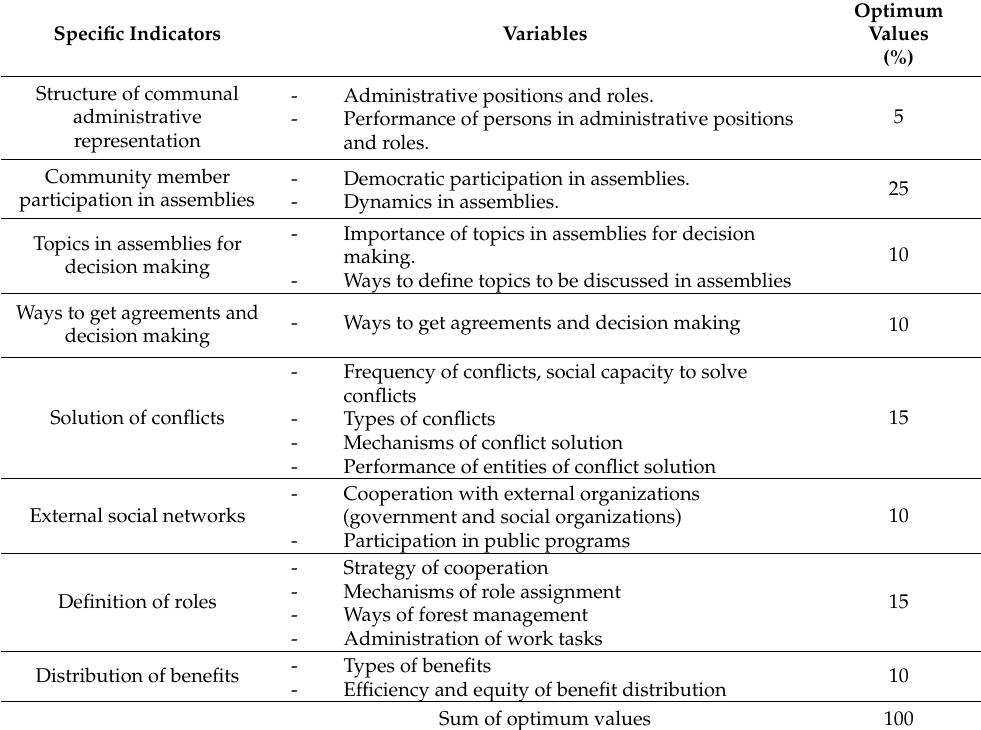
Table 5. Specific indicators and variables of the local organization.